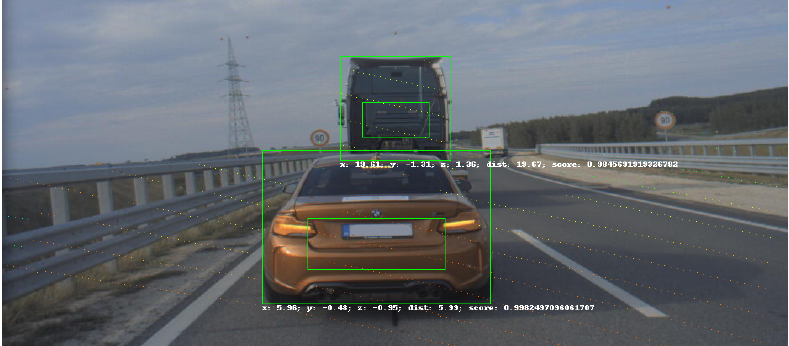
Figure 35. Point cloud projected into the image. In this recording, the Green Truck from Knorr-Bremse and the M2 type BMW from BME were followed and position information was determined for these two objects. The tracker gave the object positions in a coordinate system, where the IMU (the Inertial Measurement Unit of the on-board GNSS system) is the origin of the measurement vehicle.